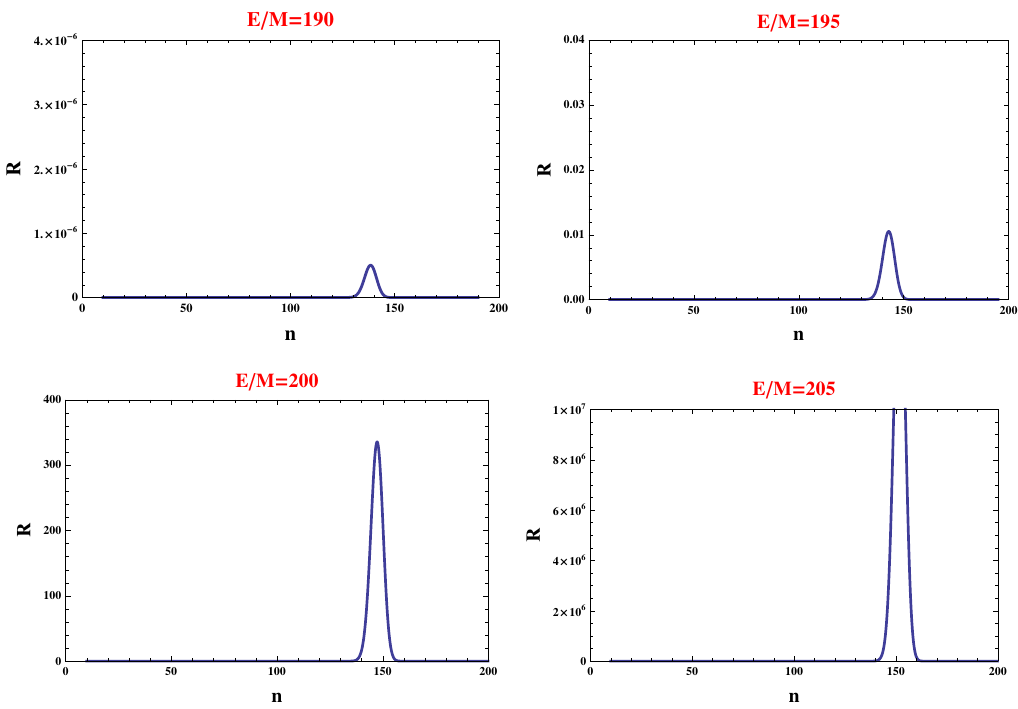
Figure 2 . Multi-particle decay rates eq. (5.2) of a highly-energetic single-particle state into n scalars plotted as function of n . The four sub-(cid:12)gures show the energy E (cid:12)xed at 190 M h , 195 M h , 200 M h and 205 M h and we used (cid:21) = 1 = 8. There is a sharp exponential dependence of the peak rate on the energy. The peak multiplicities n (cid:24) 150 in these examples are not far from the maximally allowed values at the edge of the phase space n max (cid:24) E=M h